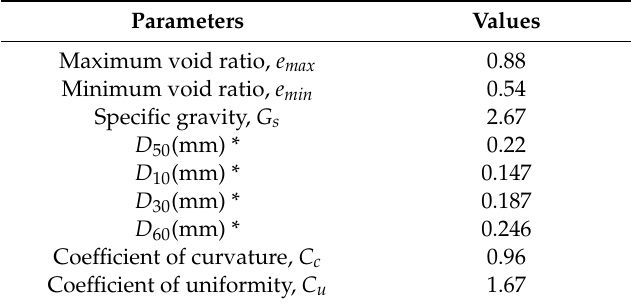
Figure 4. Grain size distribution before (unbroken) and after (broken) the performance of the triaxial test on Ramsar sand. Table 1. Basic properties of intact Ramsar sand.